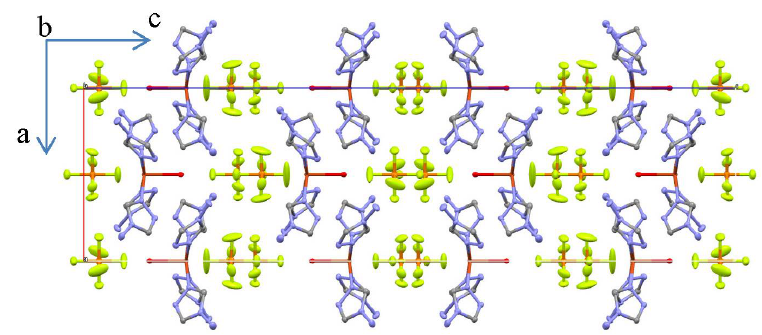
Figure 4. Thermal ellipsoid (50%) plot of II along the b axis. The nitrogen atoms are depicted in blue, the carbon atoms in grey, the fluoride atoms in green, copper atoms in red and the phosphorus atoms in orange. H-atoms were omitted for